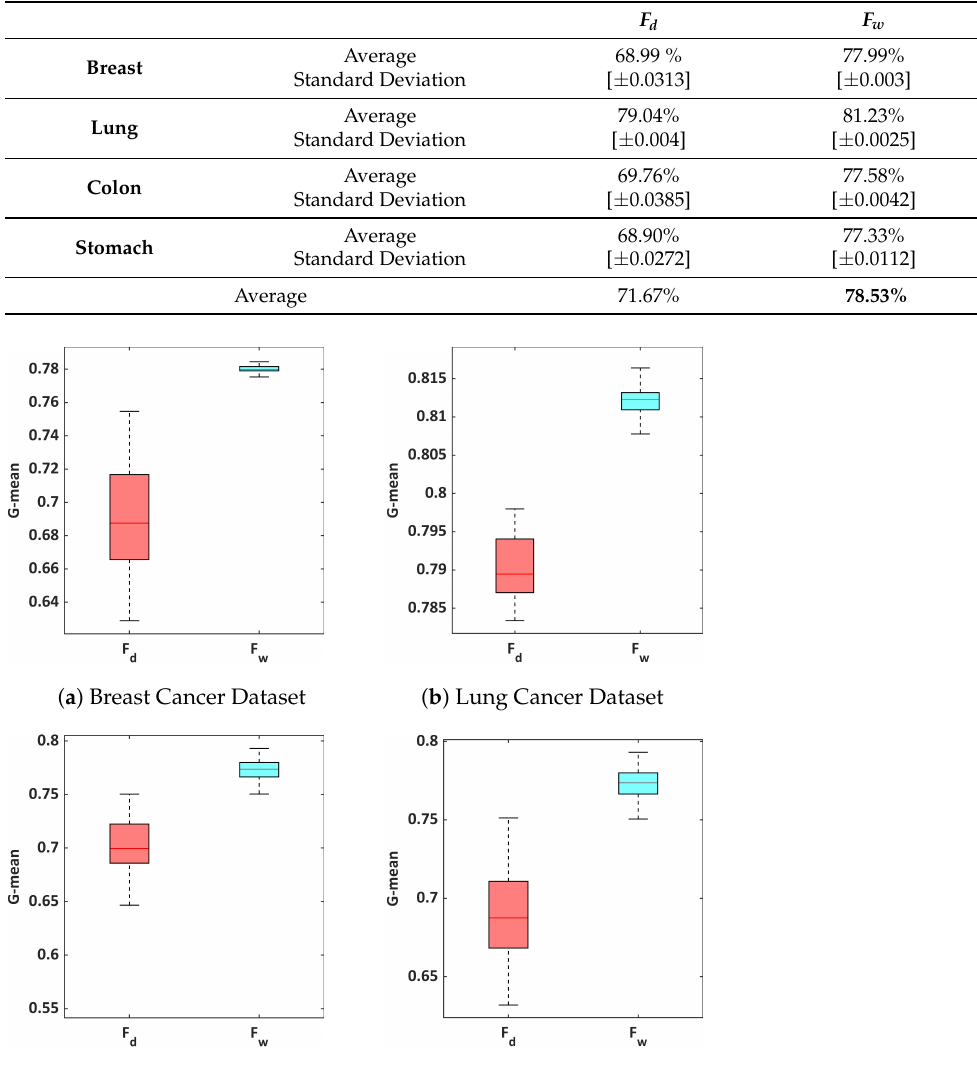
Table 4. G-mean results obtained by F d and F w .